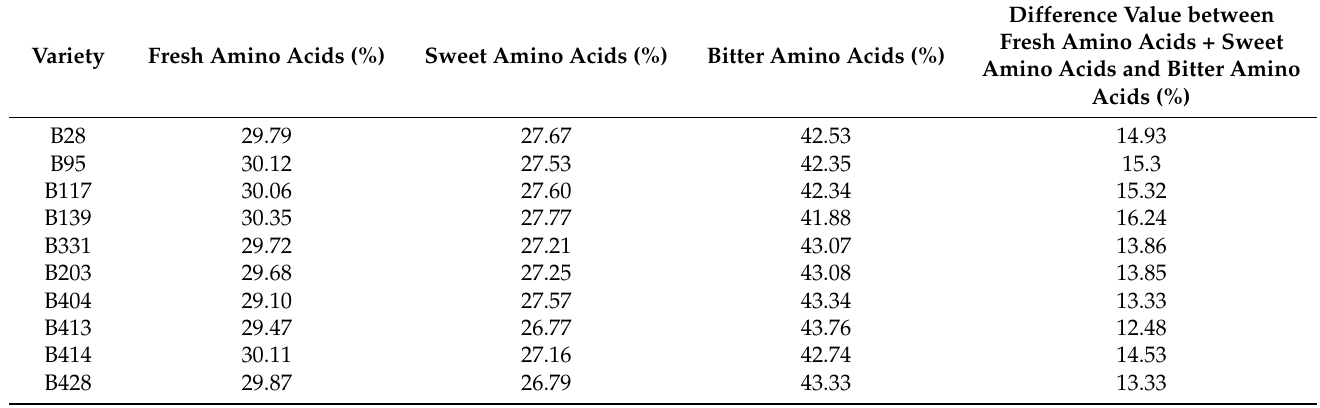
Table 3. Flavor-related amino acid content in ten varieties of foxtail millet